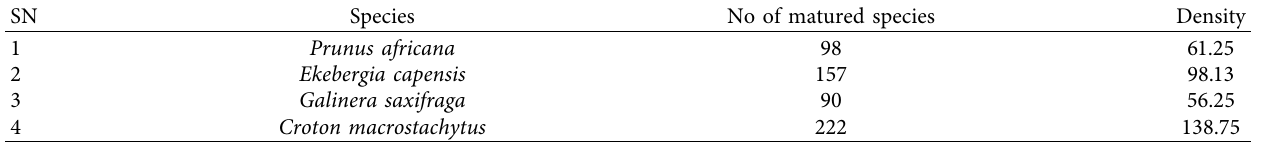
Table 2: Density distribution of four dominant tree species in the Kenech